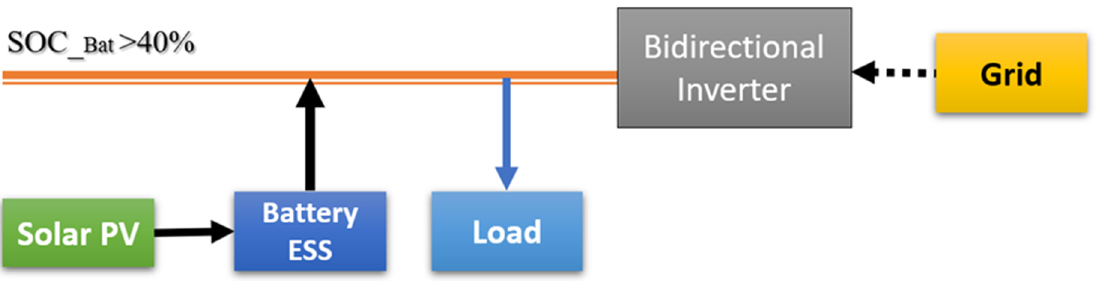
Figure 6. The optimization model during peak load hours.